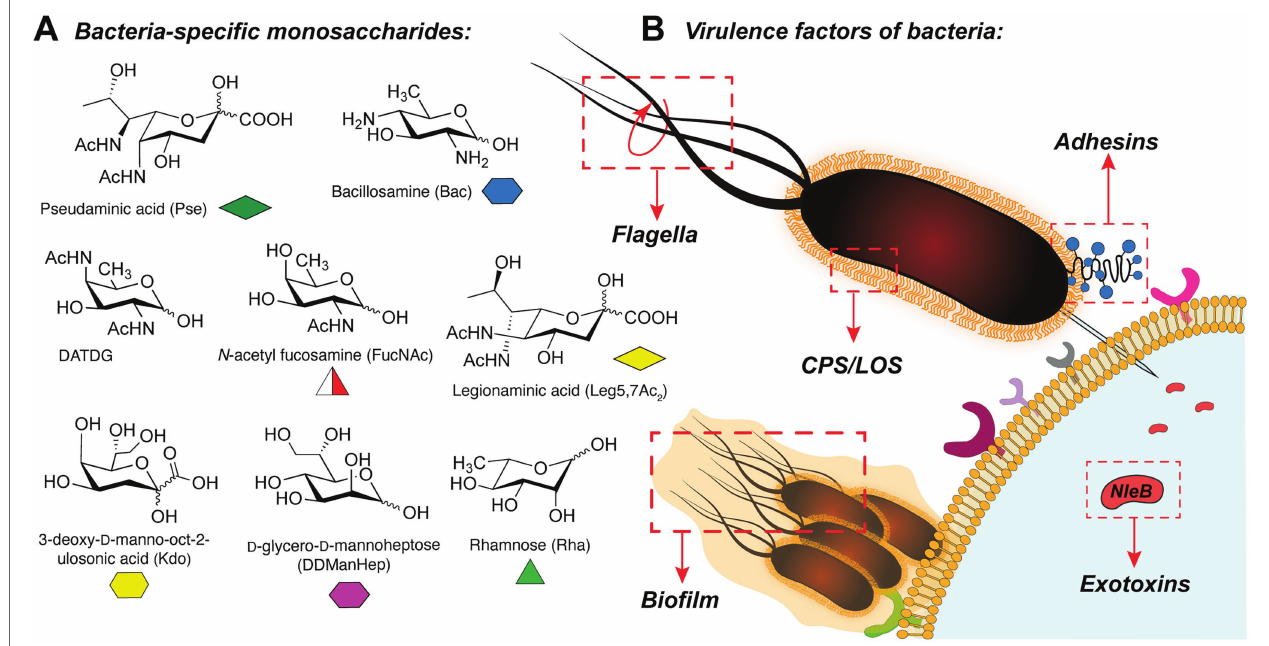
FIGURE 1 | (A) Selection of bacteria-specific monosaccharides featured in infectious glycan structures; (B) Schematic overview of the bacterial glyco-virulence factors discussed in this